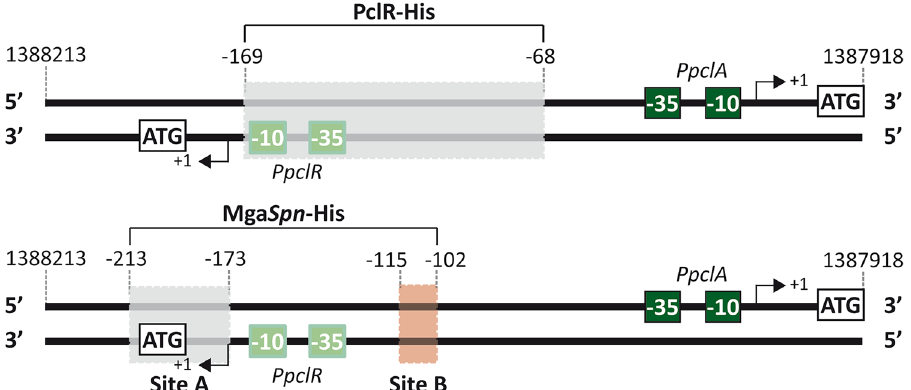
Figure 6. Sites recognized by PclR-His and Mga Spn -His in the region that contains the PpclA and PpclR promoters. The sites were defined by DNase I footprinting assays (see Figs. 4 and 5). The location of the main elements of each promoter (− 35 and − 10 boxes), as well as the transcription start site (position +1) and the translation initiation codon (ATG) of the pclA and pclR genes are indicated. The − 68, − 102, − 115, − 169, − 173 and − 213 positions are relative to the transcription start site of the pclA